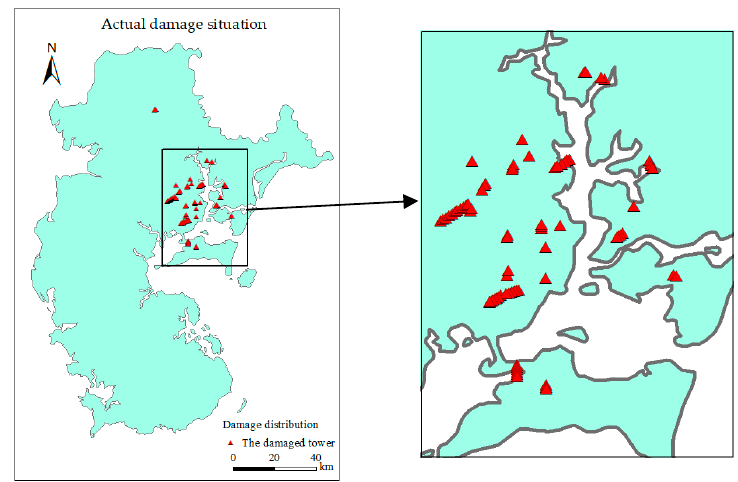
Figure 17. Actual damage situation.